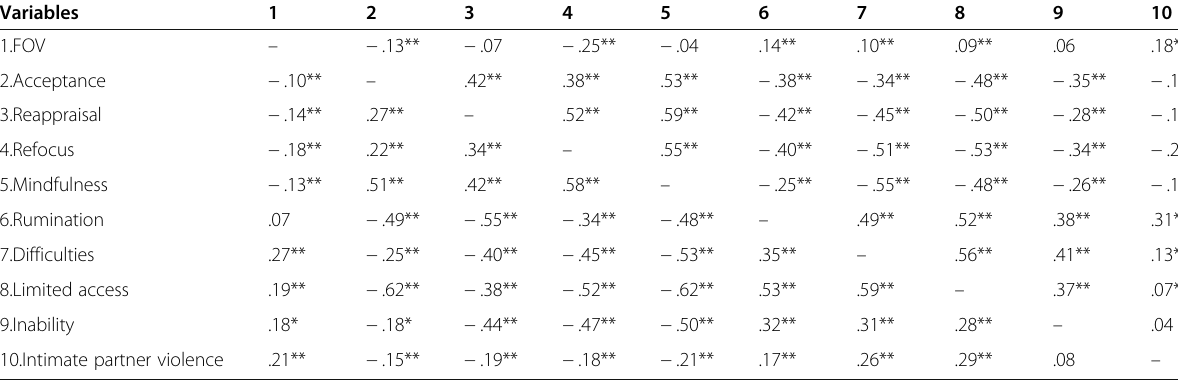
Table 2 Correlations of study variables for women and men Variables